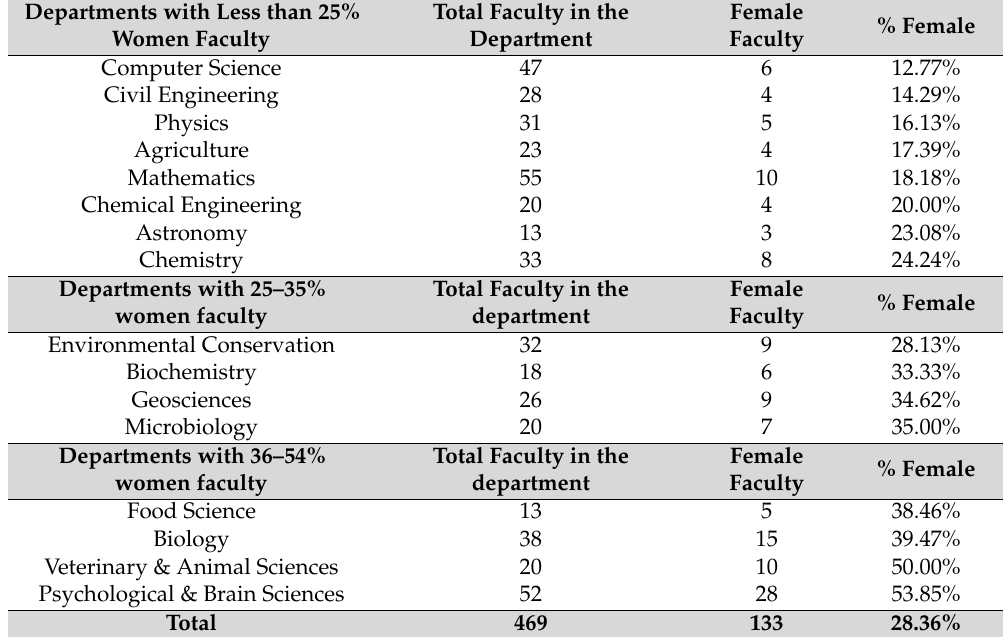
Table 1. Department Gender